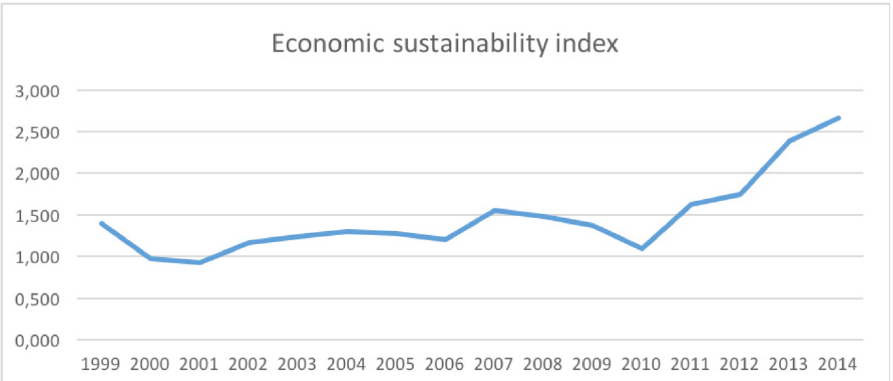
Figure 1. Evolution of Economic sustainability